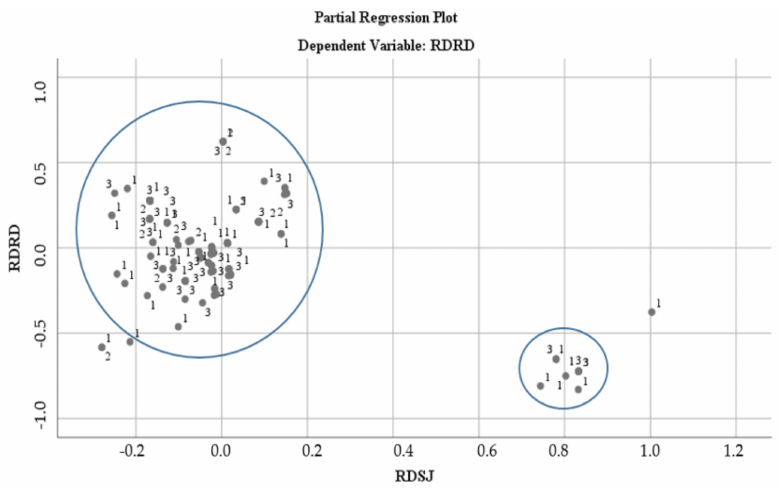
Figure 11. Regression analysis for